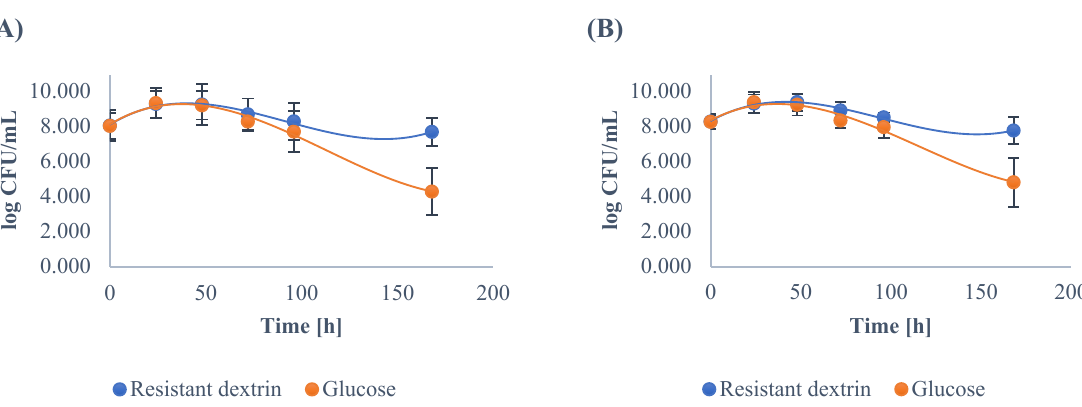
1.42 The mean results from three repetitions for 30 samples. The results are significantly different from: A the control group; B the resistant dextrin group; one-way ANOVA with post-hoc Tukey’s test ( p < 0.05). SD: Standard deviation; and Unit: log CFU/mL. The control strains were cultivated on the medium with glucose instead of resistant dextrin. Similarly to the co-culture with resistant dextrin, the control strains reached the stationary phase after the 24 h of cultivation. The number of bacteria from the genera Lac- tobacillus and Bifidobacterium were similar to each other, as well as to the number of bacte- ria grown on the medium with resistant dextrin (Table 2). They amounted to 9.36 ± 0.86 and 9.41 ± 0.60 log CFU/mL, respectively. After 168 h of incubation, the number of both Lactobacillus and Bifidobacterium dropped significantly and was equal to 4.30 ± 1.34 and 4.83 ± 1.41 log CFU/mL, respec-